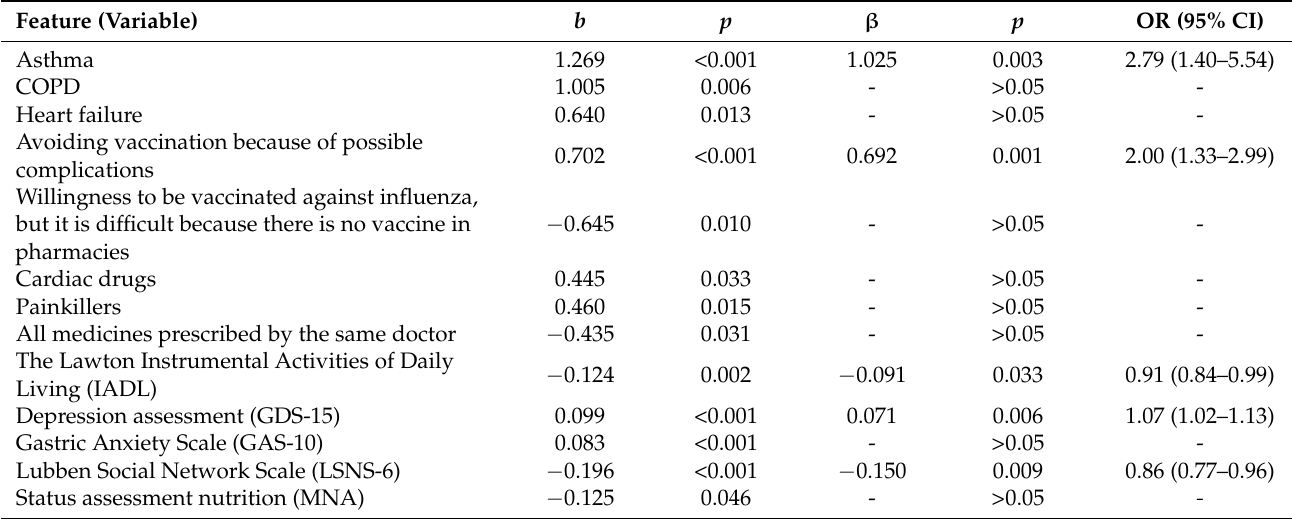
Table 5. Results of univariate and multivariate logistic regression of the answer to the question regarding difficulties with wearing a mask and/or gloves in elderly patients and socio-demographic and clinical factors as well as the odds ratio [OR] and its 95% confidence interval [CI] [the most statistically significant ( p -value < 0.05) predictors of feeling difficulties in wearing a mask and/or gloves in elderly patients during COVID-19